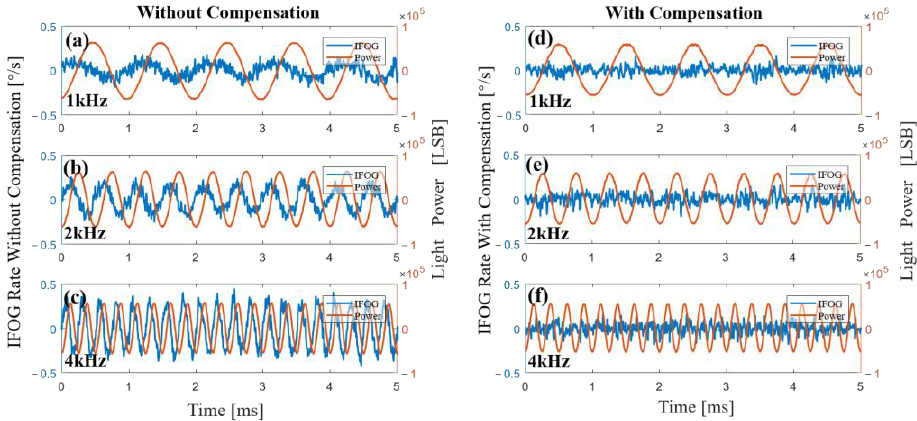
Figure 11. Experimental results of the gyroscope without ( a , c ) and with ( d , f ) compensation when the driving currents were sine waves that had the same amplitude of 1 mA but different frequencies. ( a , d ) A 1 kHz sine wave was added to the driving currents of the SLD. ( b , e ) A 2 kHz sine wave was added to the driving currents of the SLD. ( c , f ) A 4 kHz sine wave was added to the driving currents of the SLD.